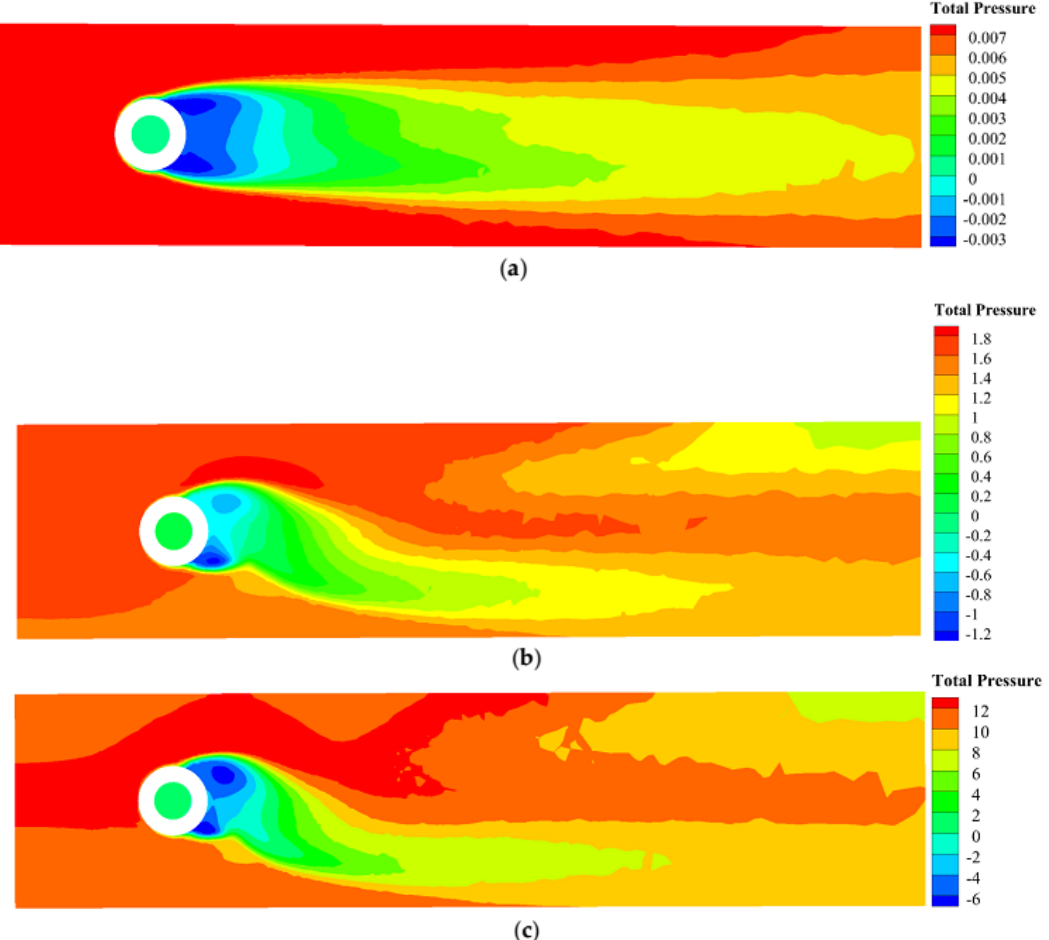
Figure 15. Distribution of total pressure in xy-plane for different inlet wind velocities: ( a ) 0.1 m/s; ( b ) 1.5 m/s; and ( c ) 4 m/s. In this figure, the unit of total pressure is